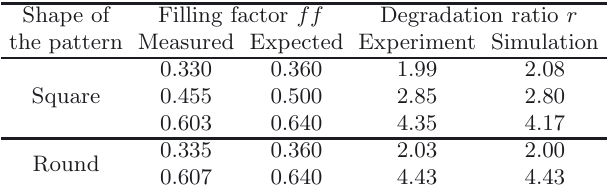
Fig. 6. TLM measurements on patterned Al layers with a pattern aligned with the metallic pads. Table 1. Degradation ratio obtained experimentally with a 100 nm thick Al layer. The theoretical values are calculated using the measured filling